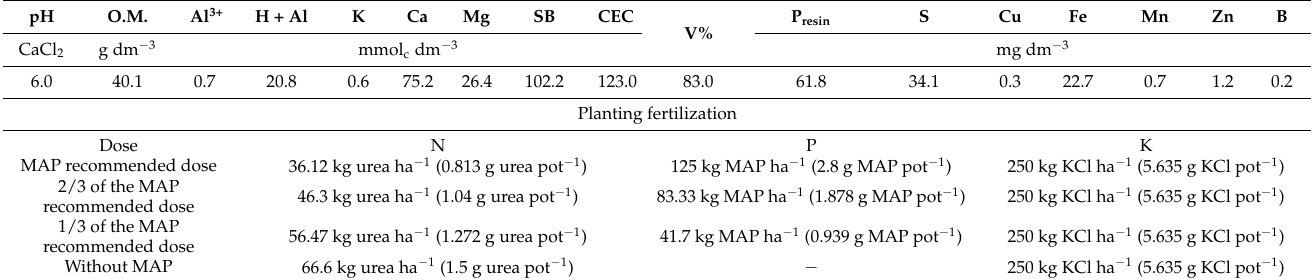
Table 1. Initial soil chemical analysis and doses of mineral fertilizers added at